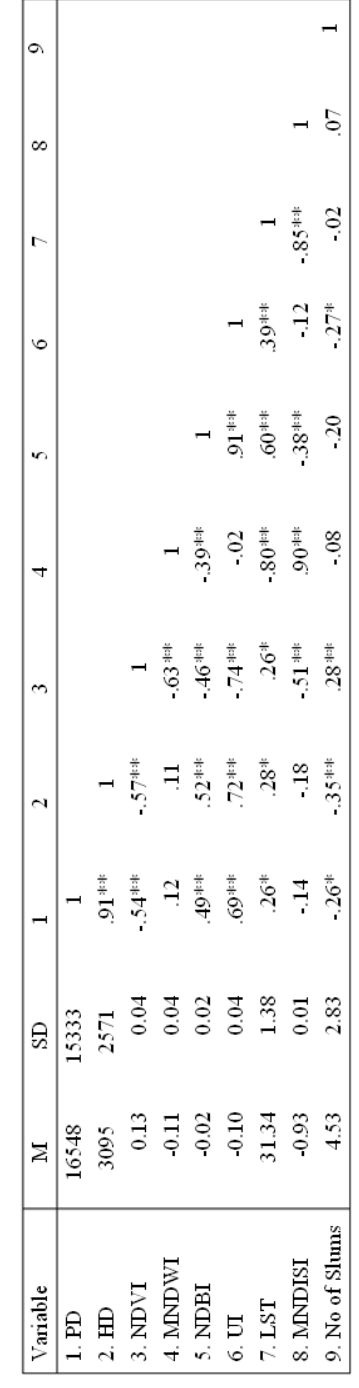
Table 1. Means, standard deviations, and